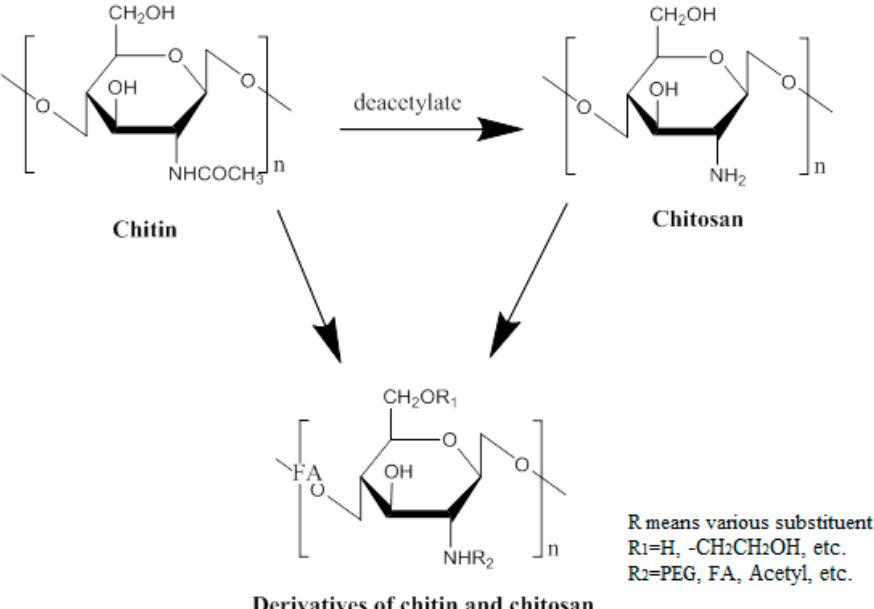
Figure 1. The chemical structures of chitin, chitosan and their derivatives.